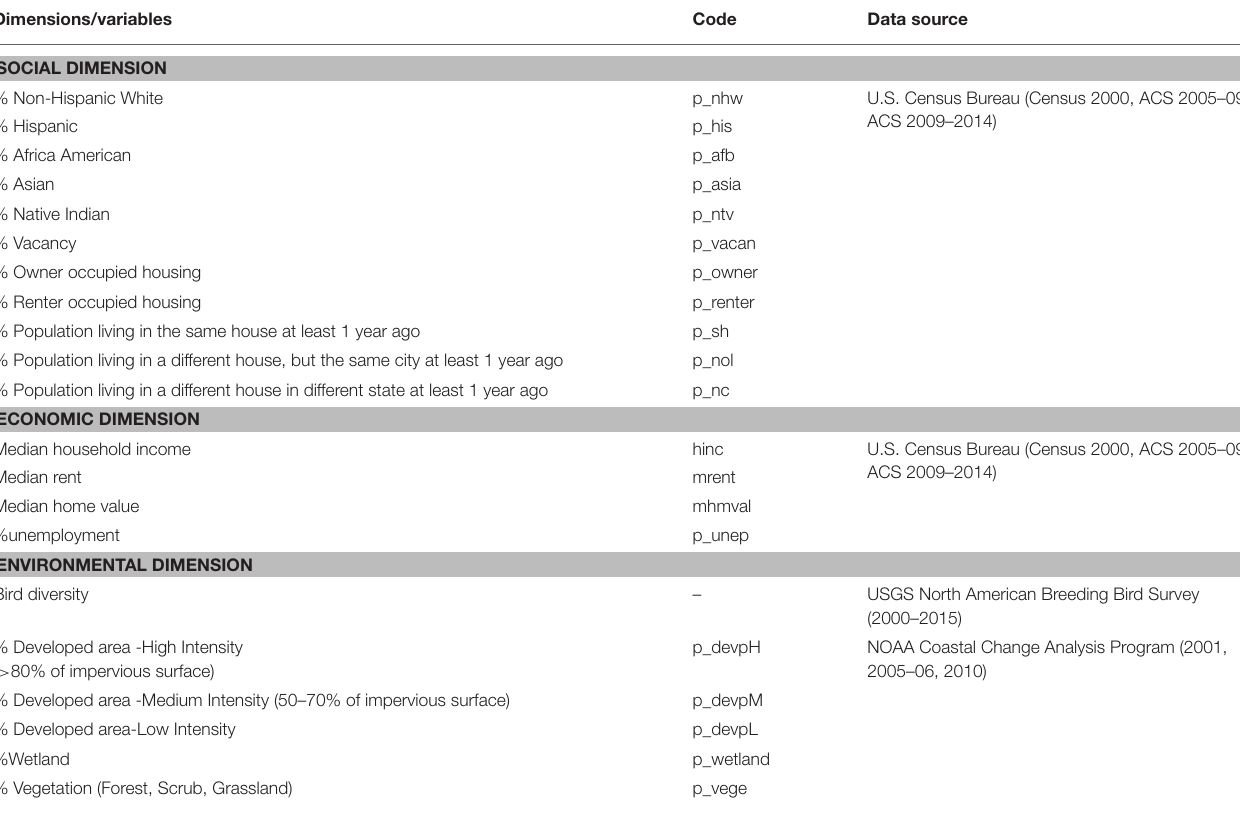
TABLE 1 | Variables and data